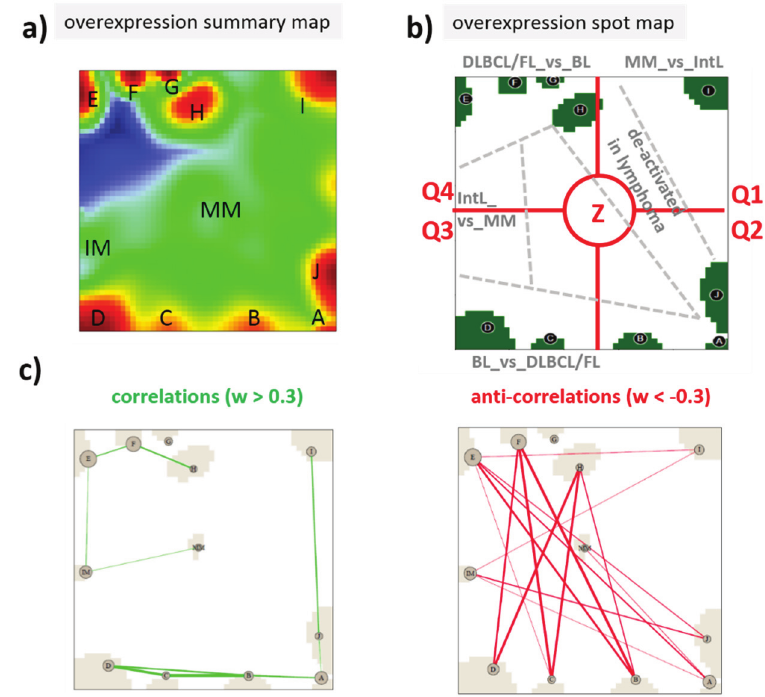
Figure 2. Expression SOM characteristics of lymphoma: ( a ) The overexpression spot summary map shows all overexpression spots in red which were detected in the lymphoma cohort studied [12]; ( b ) The spot map selects defined spot areas (A–J, IM and MM) representing clusters of co-expressed genes and overexpressed in a certain sample